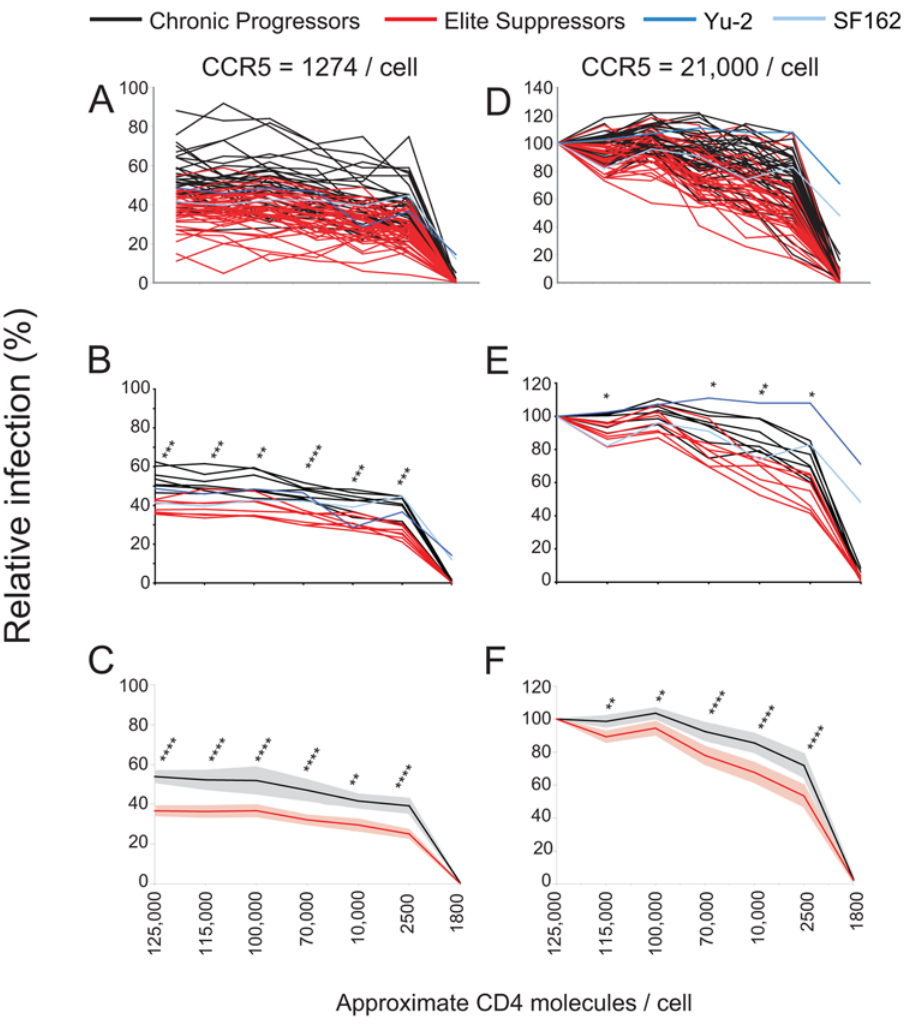
Figure 2. ES clones show reduced entry efficiency at fixed CCR5 surface concentrations. (A–C,D–F) Affinofile cells were induced to express approximately 1274 CCR5 molecules/cell (A–C) or approximately 21,073 CCR5 molecules/cell (D–F) and CD4 molecules ranging from approximately 1,800 to 125,000 molecules/cell prior to infection. Induced Affinofile cells were infected with equivalent amounts of pseudotyped viruses. Relative infection of all CP (black) and ES (red) clones are shown with SF162 and YU-2 included as positive controls (blue). Relative infection is expressed as a proportion of maximal infection at the highest CD4 (approximately 125,000 molecules/cell) and CCR5 (approximately 21,073 molecules/cell) level. (B,E) Infectivity of clones from individuals were averaged and plotted as a single line for chronic and ES individuals. P values are given for patient averages. (n=7) (C,F) Average of all individual chronic or elite clones at minimal (C) and maximal (F) CCR5 concentrations with CD4 concentrations ranging from approximately 1,800 to 125,000 molecules/cell. Affinofile cells were induced as described above for (A,B). P values as calculated by unpaired student’s t test are shown above each CD4 expression condition. P values are represented as follows: P , 0.05 (*), P , 0.01 (**), P , 0.001 (***), P , 0.0001 (****). 95% confidence intervals are shown for chronic (grey) and ES